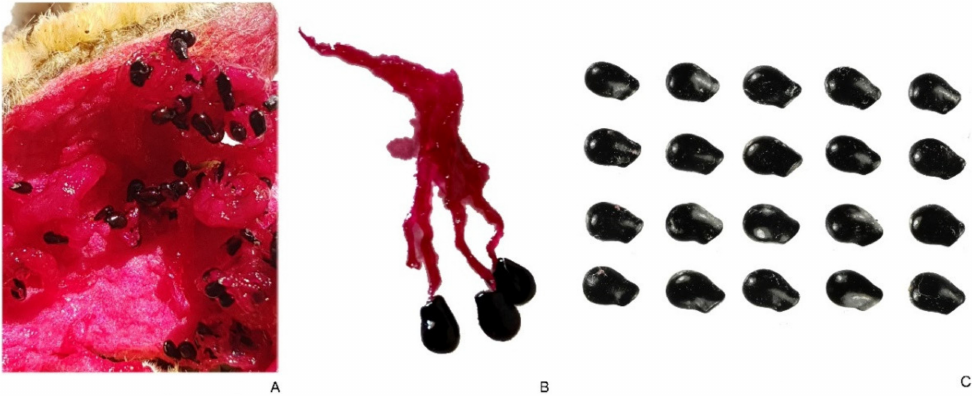
Figure 6. Pachycereus pringlei . ( A ) Seeds in a fruit. ( B ) Three seeds isolated with their funicles. ( C ) Seeds. Bar equals 1